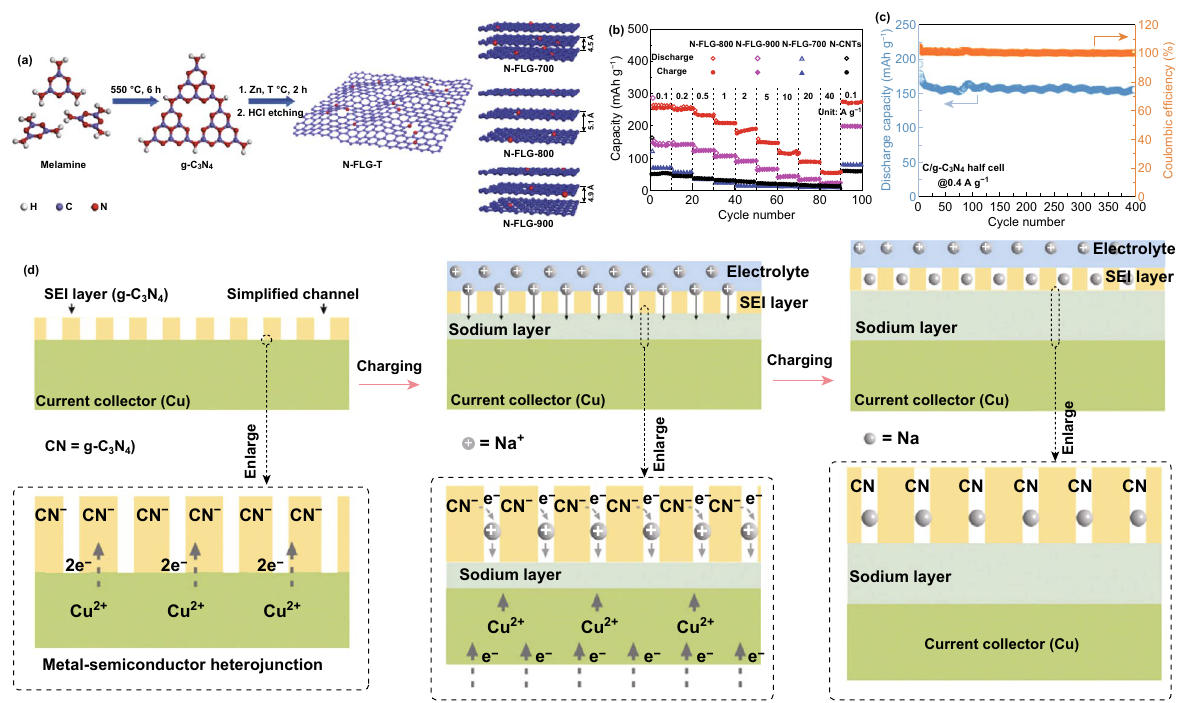
Fig. 20 a Schematic illustration of the synthetic routes for the fabrication of N-FLG-T. b Rate capability of N–CNTs and N-FLG-T at various current densities. Reproduced with permission from Ref. [128]. c Cycling performance of C/g-C 3 N 4 Na half cells at 0.4 A g −1 . Reproduced with permission from Ref. [53]. d Illustration of the mechanism of the sodium storage in g-C 3 N 4 film activated Cu foil. Reproduced with permission from Ref. [129]. Copyright permission from Wiley–VCH. (Color figure online)